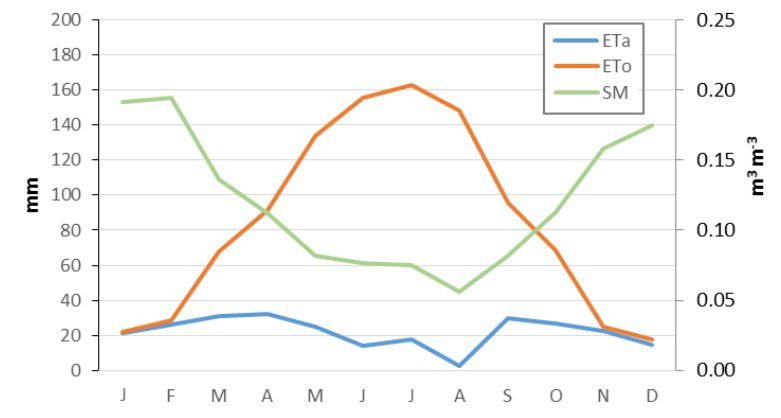
Figure 12. Monthly actual evapotranpiration ( ET a , blue line) from HidroMORE, potential evapotranspiration ( ET 0 , red line), and SM (green line) from the REMEDHUS network along